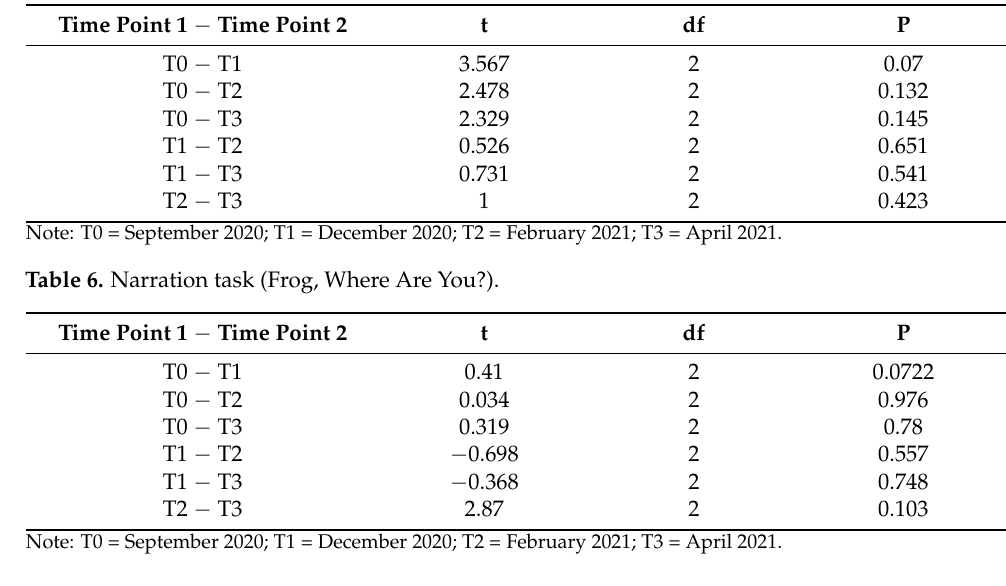
Table 5. Picture description.